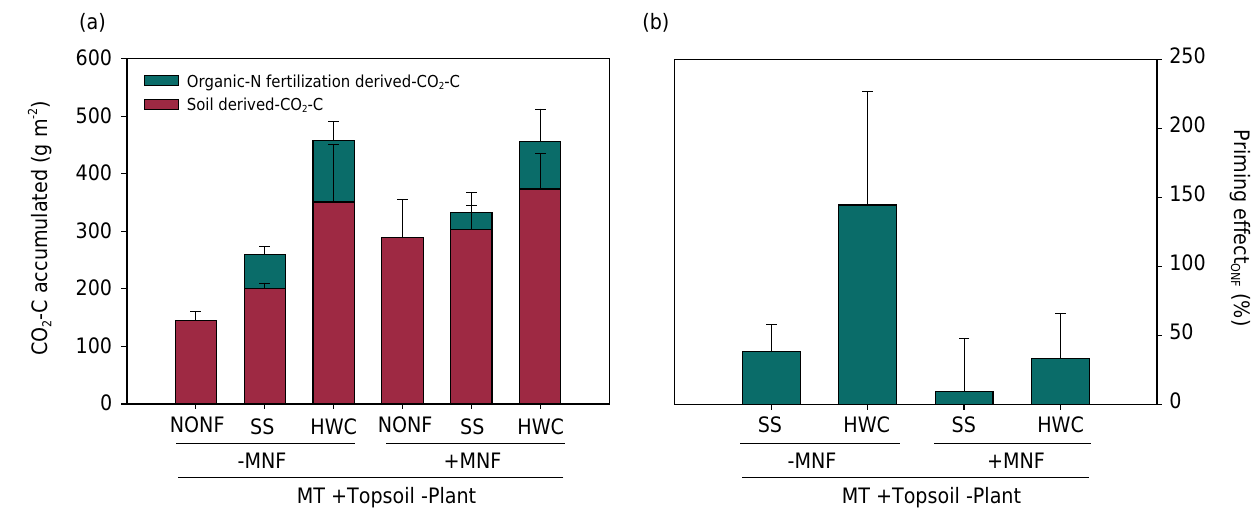
Figure 4. Organic-N fertilization derived-CO 2 -C and Soil derived-CO 2 -C accumulated (g m -2 ; a) and priming effect ONF (%; b) 78 days after sowing in iron mining tailing + Topsoil (MT + Topsoil), without (-Plant), without (-MNF) and with mineral-N fertilization (+MNF) and different organic-N fertilization (non-organic-N fertilization, sewage sludge - SS, and household waste composting - HWC). Vertical bars represent the means ± 90 % confidence interval (n =